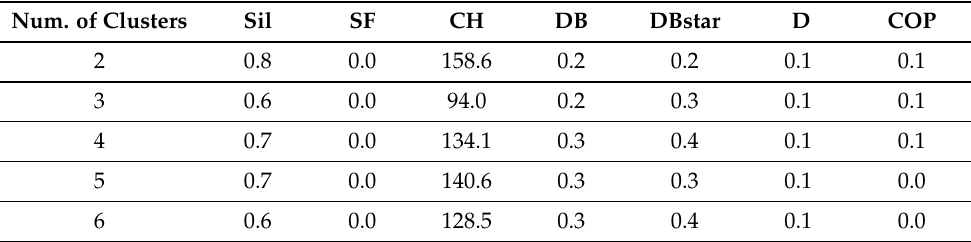
Table 1. Cluster validity indices.